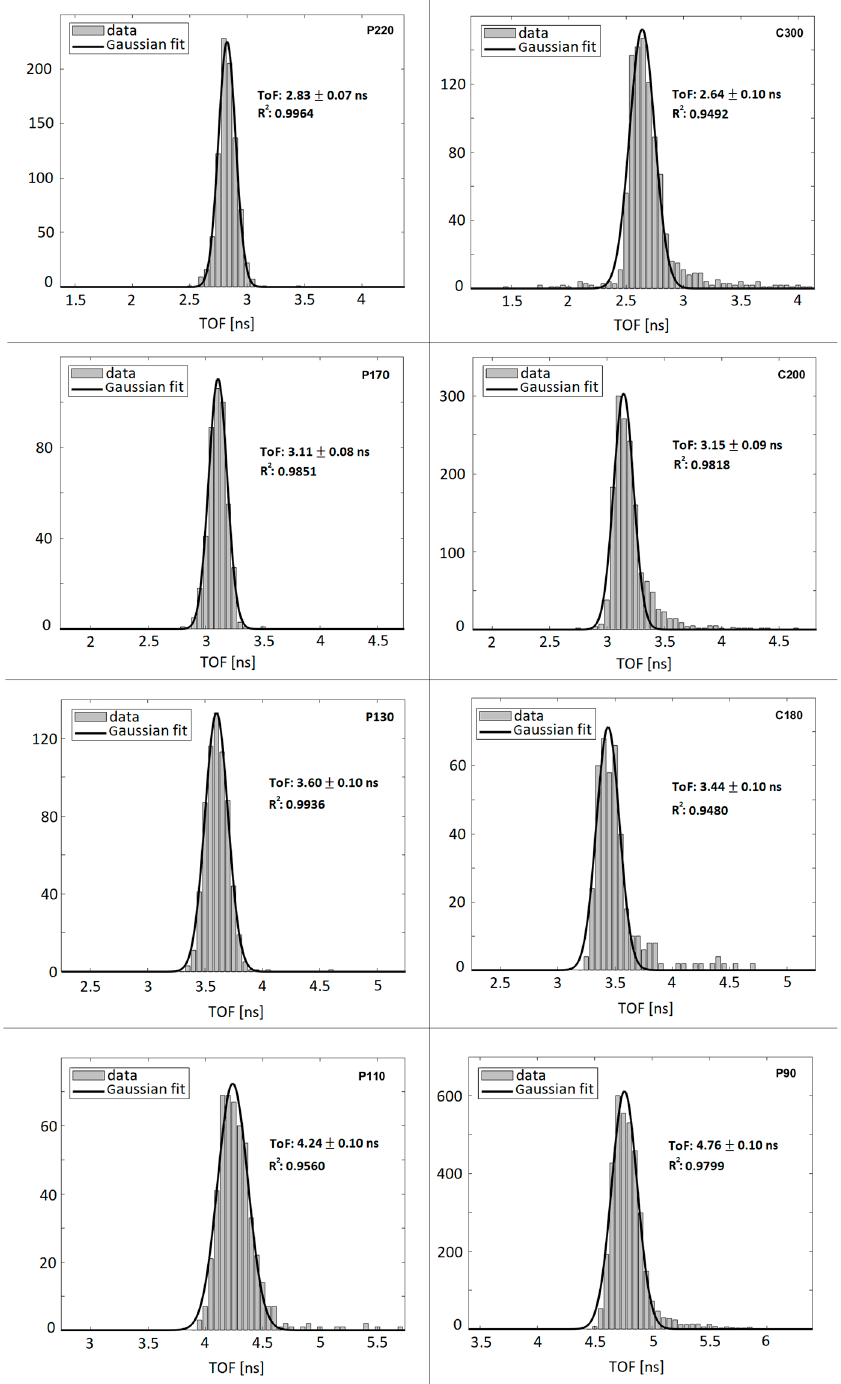
Figure 5. ToF distributions (in ns) with Gaussian fits superimposed for protons and carbon ions at different energies. Time resolution has proven to be between 70 and 100 ps, regardless of the scintillators hit by the particle beam.